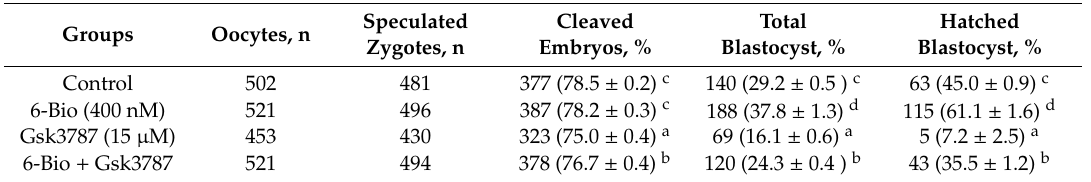
Table 2. Co-treatment with 6-Bio rescued the inhibitory e ff ect of PPAR δ antagonist (Gsk3787) on embryonic development to the BL stage and